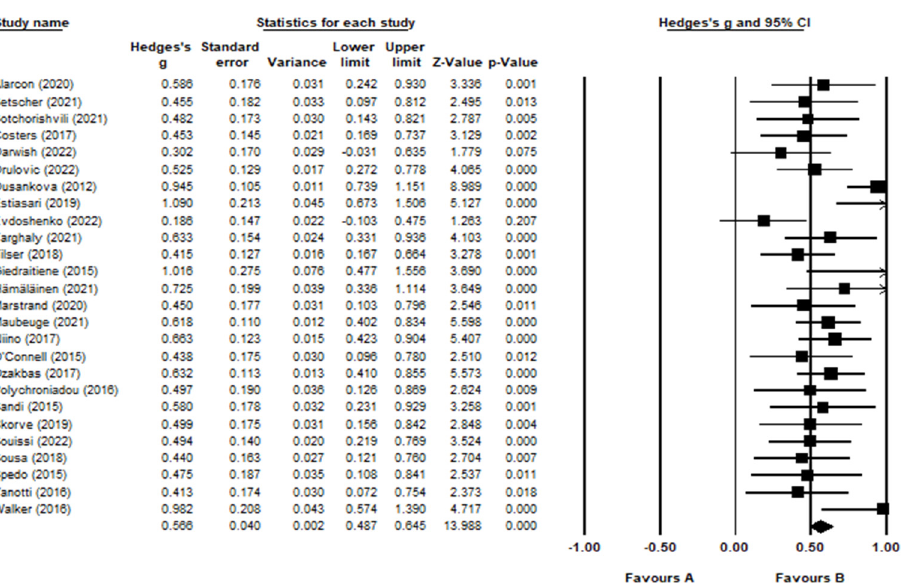
Figure 6. Forest plot for BVMT-R. Alarc ó n et al. [46]; Betscher et al. [47]; Botchorishvili et al. [48];